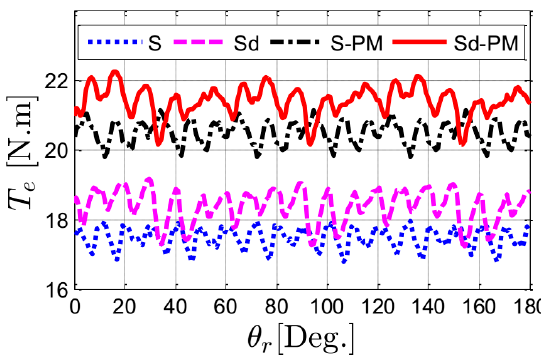
Figure 6. SynRM output torque ( T e ) as a function of mechanical rotor angle ( θ m ) at rated conditions and optimal current angles.